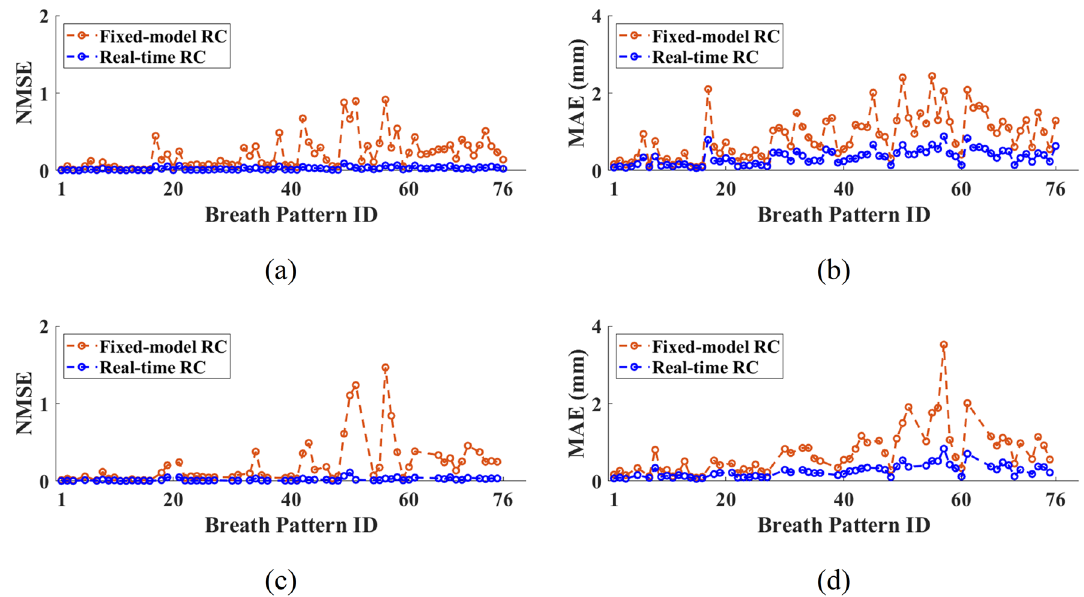
Figure 7. Comparison of the fixed-model RC and real-time RC motion prediction. ( a )–( b ): real-time RC t tr = 20 s, fixed-model RC t tr = 20 s; ( c )–( d ): real-time RC t tr = 0 s, fixed-model RC t tr = 60 s. (Testing conditions: N = 14 , N ′ = 12 , h p = 10, t p = 333